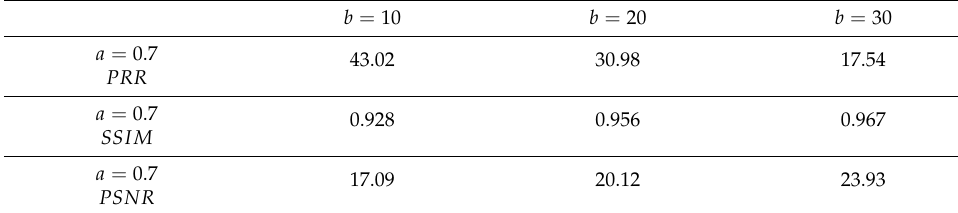
Table 6. Baboon image without HE for a = 0.7.